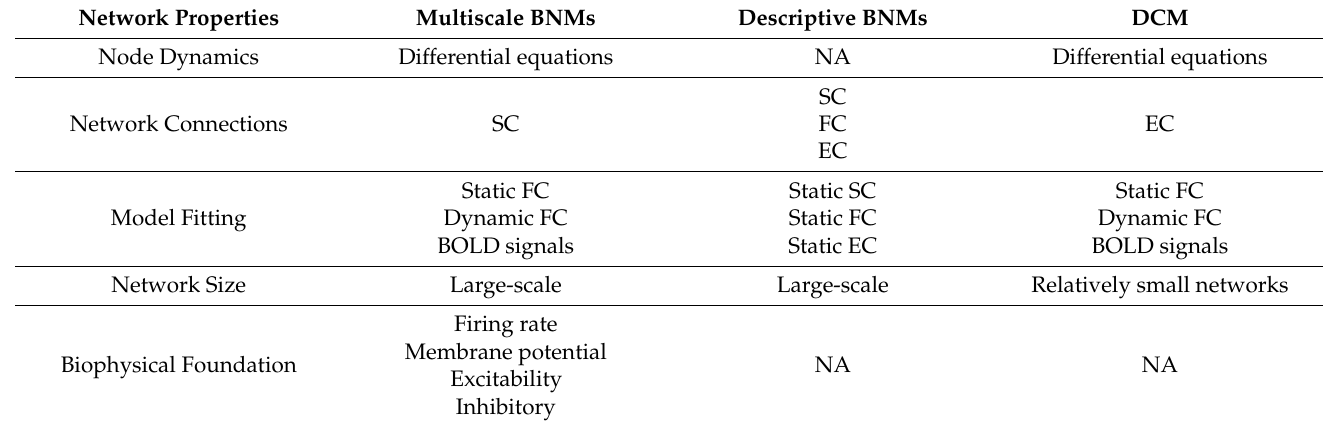
Table 1. Comparison between multiscale BNMs and other brain